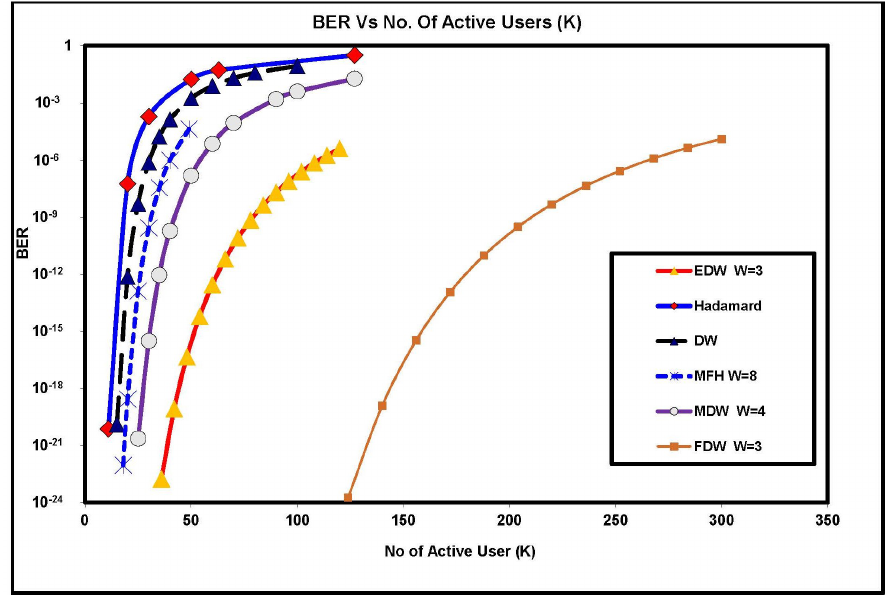
Figure 2. Performance of OCDMA code BER versus the number of users (K).